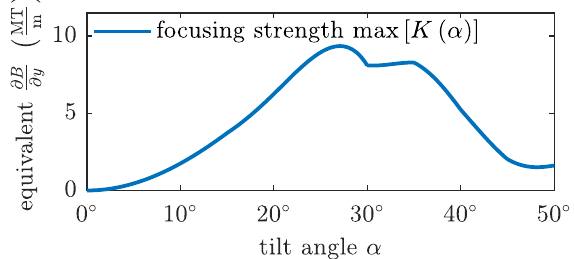
FIG. 6. Tilt angle – dependent quadrupole focusing of a syn- chronous DLA undulator at maximum K ð α Þ for φ E 0 ¼ 10 GV = m field amplitude with an optimum at α ≈ 27 °.